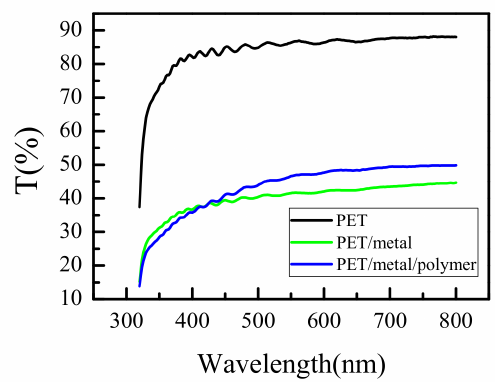
Figure 3. Measured transmittance spectra of bare PET substrate, PET substrate covered with Au:Pd layer and metalized PET covered with polymer film.